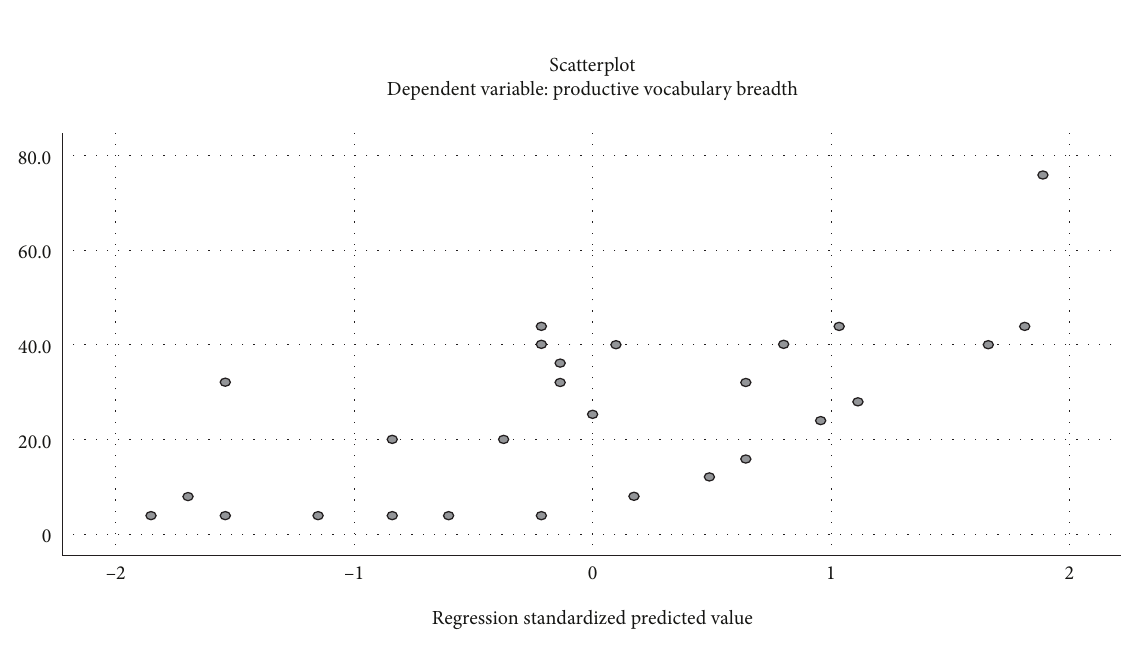
F IGURE 2: Scores